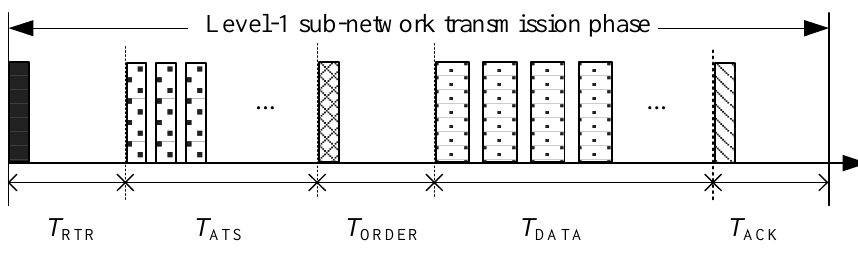
Figure 9. The transmission period of RSV-MAC protocol.